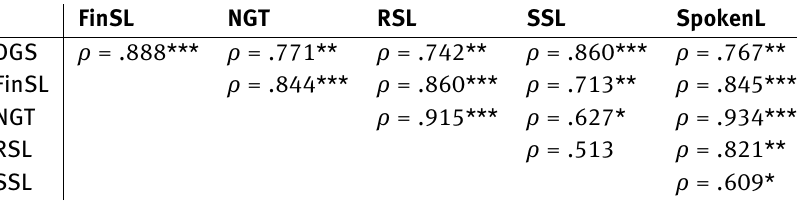
Table 3: The statistical rank correlation across ValPaL verb meanings within each language dyad for our five sign languages and the combined spoken languages from Haspelmath (2015). Locative arguments are excluded for the sign